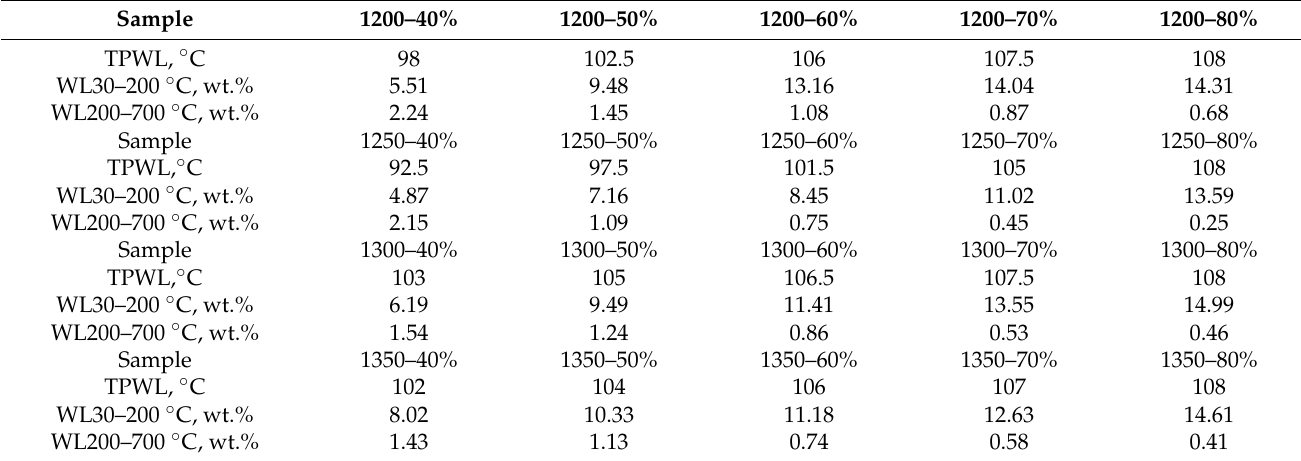
Table 5. TG results of the SAC-MKPC hydration product at 28